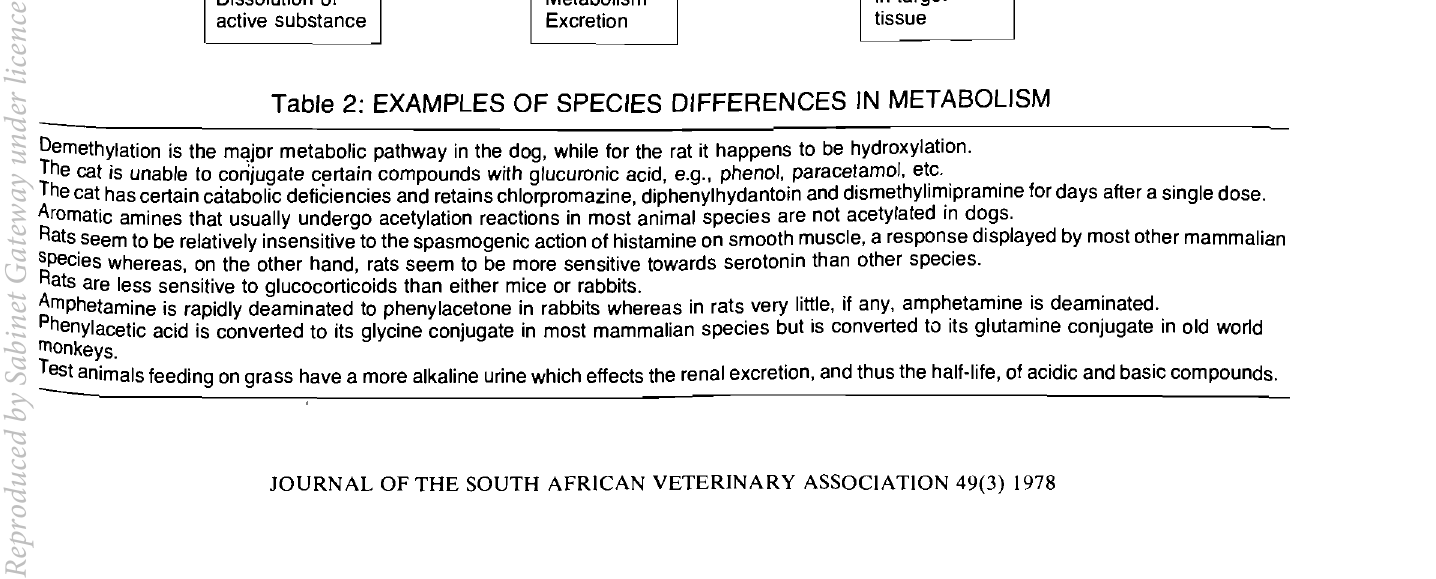
Table 2: EXAMPLES OF SPECIES DIFFERENCES IN METABOLISM